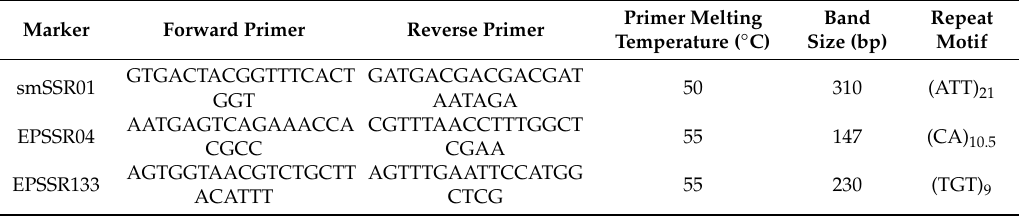
Table 6. DNA sequence of primers, PCR conditions, and characteristics of the Simple Sequence Repeat (SSR) markers used for hybridity confirmation for interspecific hybrids developed between cultivated eggplant and wild